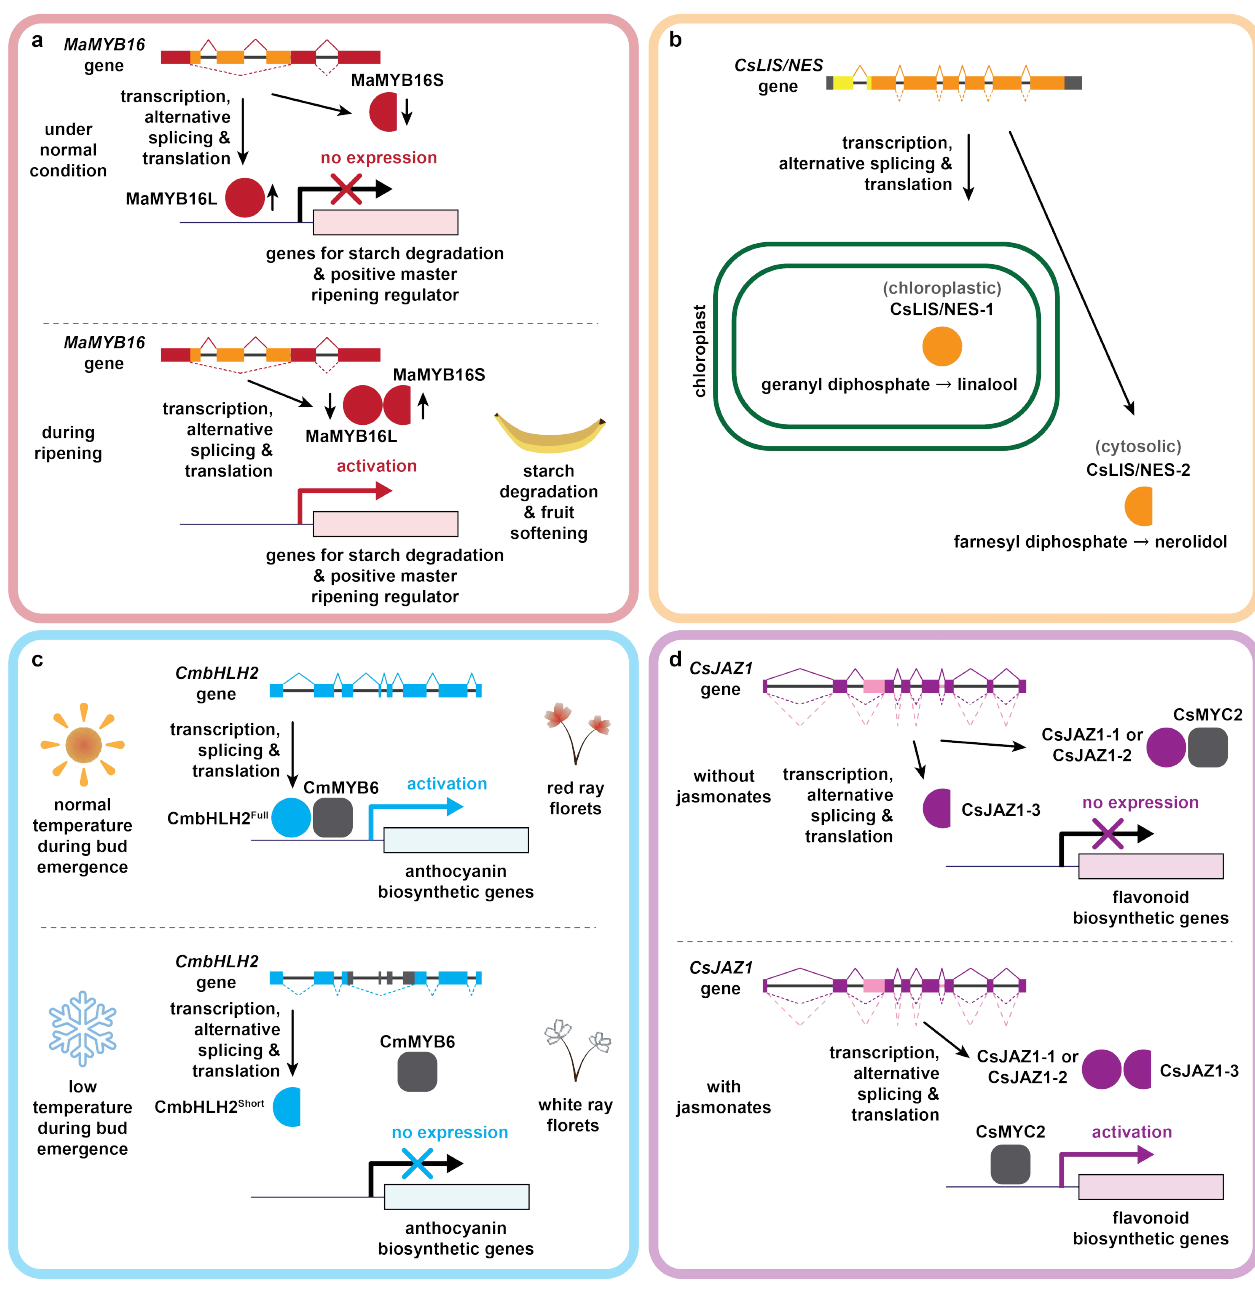
Figure 3. Examples of plant metabolism regulated by alternative splicing. ( a ) Regulation of tran- scription factor MaMYB16 in banana by alternative splicing and its roles in starch metabolism; ( b ) regulation of CsLIS/NES in tea plants by alternative splicing and its roles in linalool and neroli- dol biosynthesis; ( c ) regulation of CmbHLH2 in chrysanthemums by alternative splicing and its roles in anthocyanin biosynthesis and floret coloration; ( d ) regulation of JASMONATE ZIM-domain (JAZ) repressor in tea plants by alternative splicing and its roles in jasmonate-mediated flavonoid